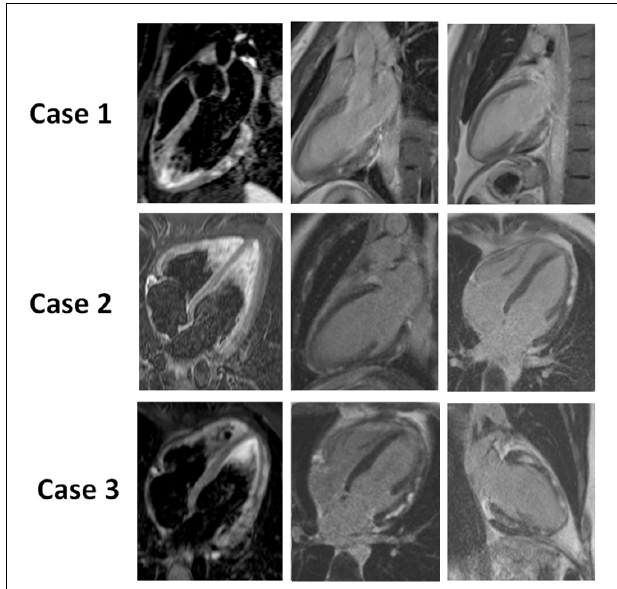
FIGURE 2 | CMR of 3 patients with acute myocarditis: Case 1: a 21-year-old male patient with chest pain and ST elevation. CMR shows a marked focal edema (T2 STIR) and an intramyocardial nodular LGE of the inferolateral wall. Case 2: a 28-year-old male patient with chest pain, dyspnea, ST depression and elevated troponin. CMR shows no focal edema (T2 STIR) and a subepicardial nodular and linear LGE of the latero-apical and infero-apical walls. Case 3: a 33-year-old female patient with chest pain, palpitations, negative T waves and elevated troponin. CMR shows a moderate focal edema (T2 STIR) of the latero-apical wall and a diffuse intramyocardial and subepicardial, nodular and linear LGE. Images in the left panel of the figure are obtained in Black blood T2-weighted short-inversion-time inversion-recovery (STIR) sequence and allow the identification of edema. Images of the mid and right panel are based on inversion-recovery prepared T1-weighted sequences, performed 10 min after intravenous administration of gadolinium chelate and allow the identification of